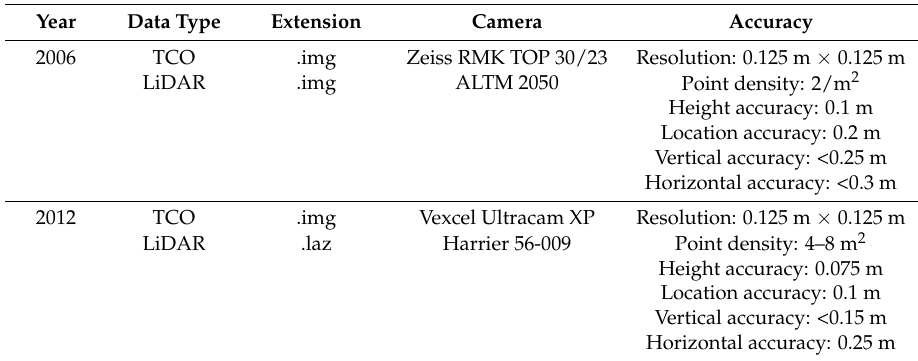
Table 1. Metadata of the used